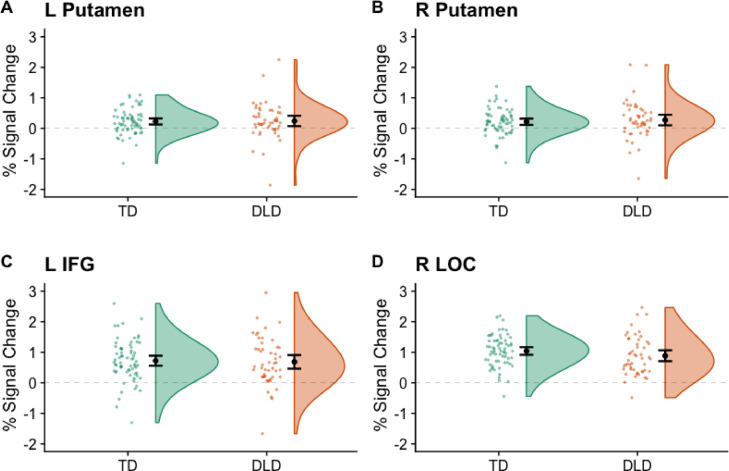
Percent BOLD signal change in TD (green) and DLD children (orange) in A) L Putamen, B) R Putamen, C) L Inferior Frontal Gyrus, pars triangularis, and D) R Lateral Occipital Cortex – plots show mean +/- 95% confidence intervals. Individual datapoints are shown alongside violin plots, with jitter added along the X dimension to aid visualisation.